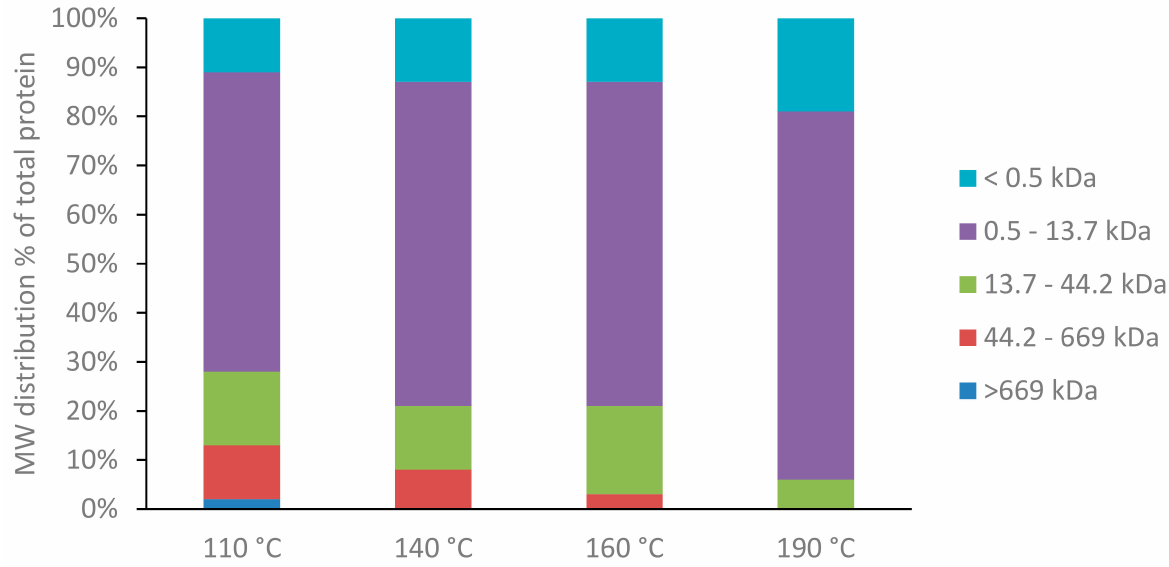
Figure 5. Molecular weight distribution of the proteinaceous compounds in chicken bone PHW